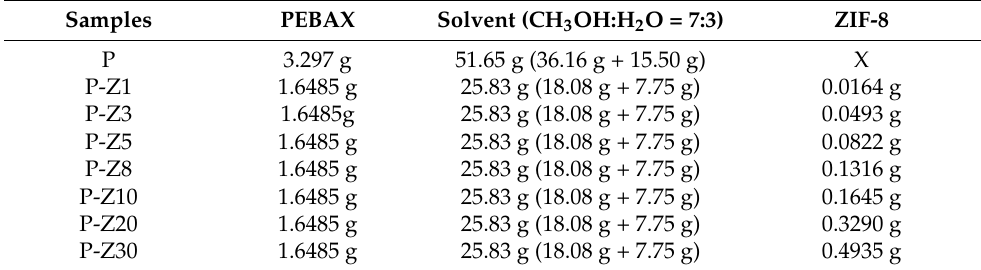
Table 1. Metal-organic framework (MOF) ratios for preparation of casting solution.